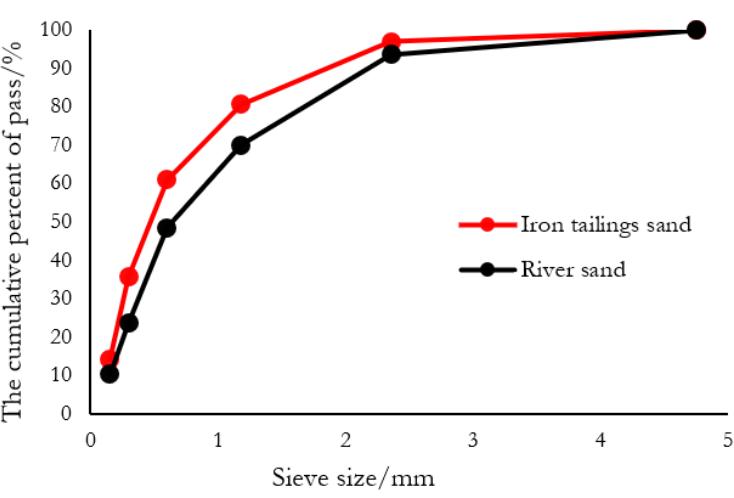
Figure 1: Grain size distributions of